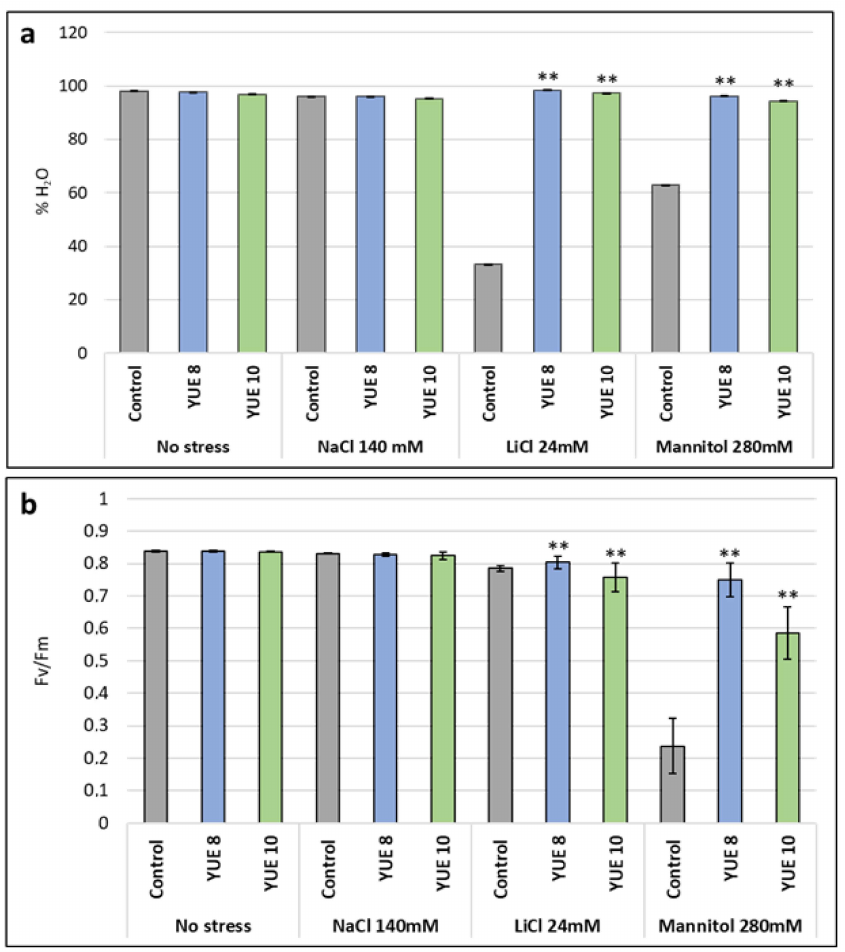
Figure 4. Effect of yucca extracts YUE 8 and YUE 10 on the physiological parameters of A. thaliana Col-0 WT plants under abiotic stress conditions. ( a ) Percentage of water content of the plants. ( b ) chlorophyll a yield index of the leaves. The X -axis indicates the different concentrations of abiotic stressors. Control without extract (gray); YUE 8 (blue) and YUE 10 (green), while the Y -axis represents the chlorophyll a yield index (Fv/Fm is presented as a ratio of variable fluorescence (Fv) over the maximum value of fluorescence (Fm)). The bars represent a standard error. ** indicates significant differences at p < 0.01 according to Student’s tests compared to the